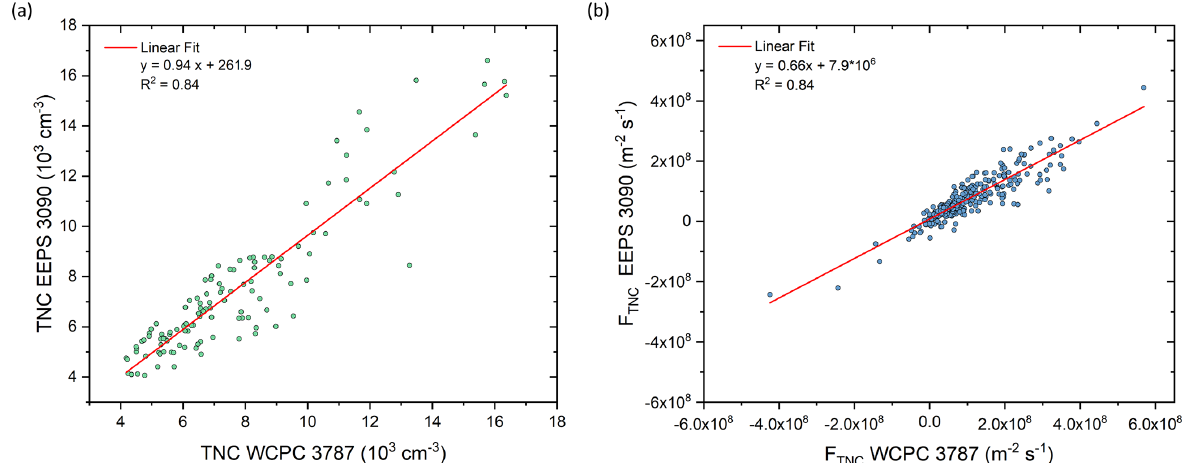
Figure A2. Measurement comparison of the EEPS 3090 with the WCPC 3787 at the Berlin site concerning (a) total particle number concentration (TNC, 4d, July 2020) and (b) total particle number flux ( F TNC , 12d, September 2020). The EEPS data relate to particle sizes between 10 and 200nm, whereas the WCPC counts particles with D p > 5nm.